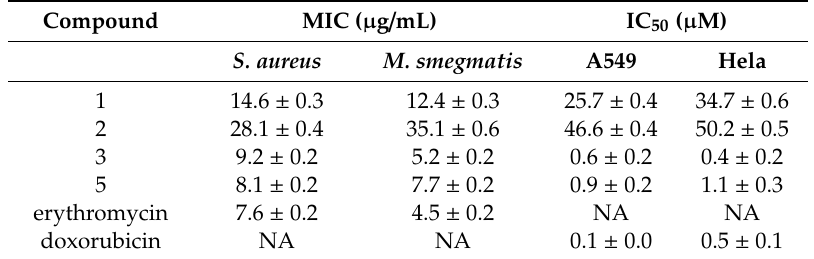
Table 4. The MIC values and IC 50 values of 4 compounds against microorganism and tumor cell lines,